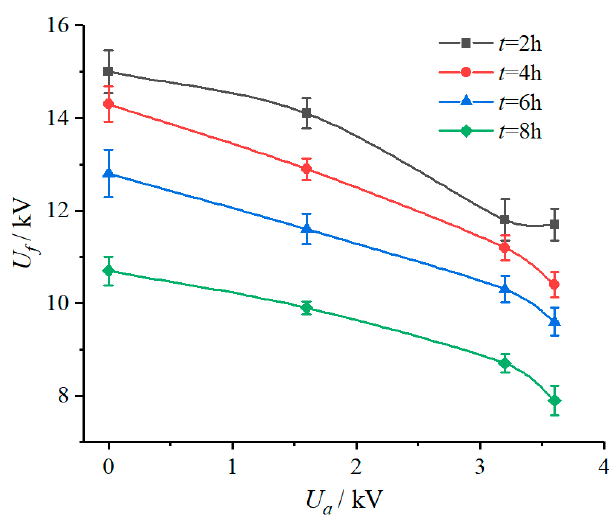
Figure 6. Relationship between U f and U a ( γ 20 = 3000 µ S / cm).